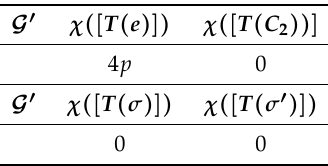
Figure 1. Geometric effect of the C 2 ν symmetry operations. Table 2. Character table for the reducible representation G (cid:48) of C 2 ν